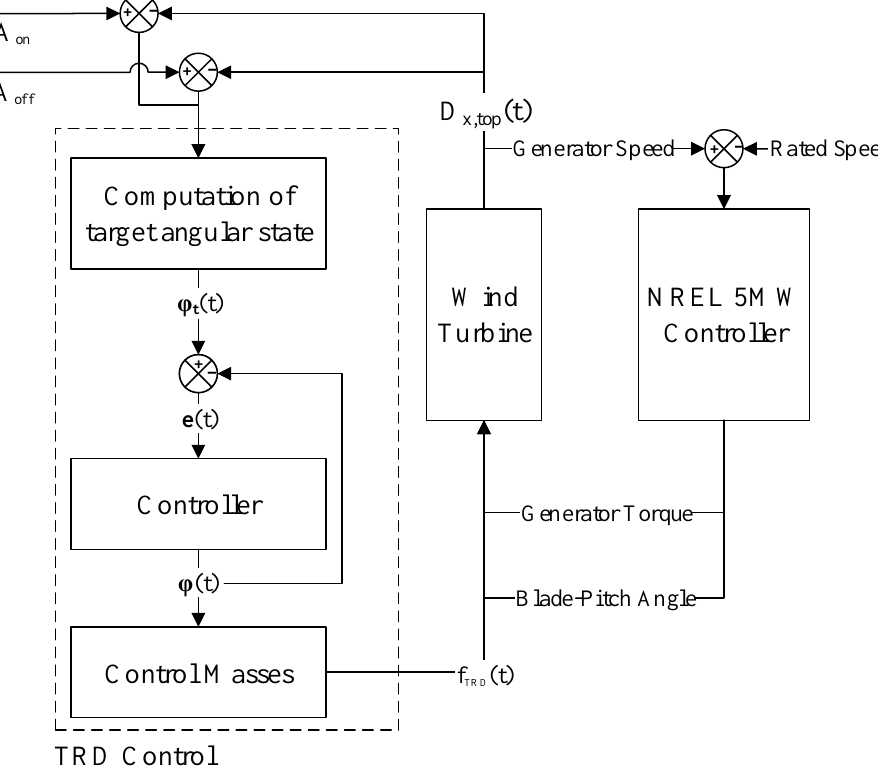
Figure 6. Integration of TRD control to the NREL 5MW reference wind turbine control. In Figure 6, the default control system of NREL 5MW reference wind turbine [41] is simplified on the right side while the proposed TRD control is represented on the left. The tower-top deflection D x , top is computed and fed back to the controller of TRD. It is compared to two thresholds of vibration amplitude, A on and A of f , in the way given in Algorithm